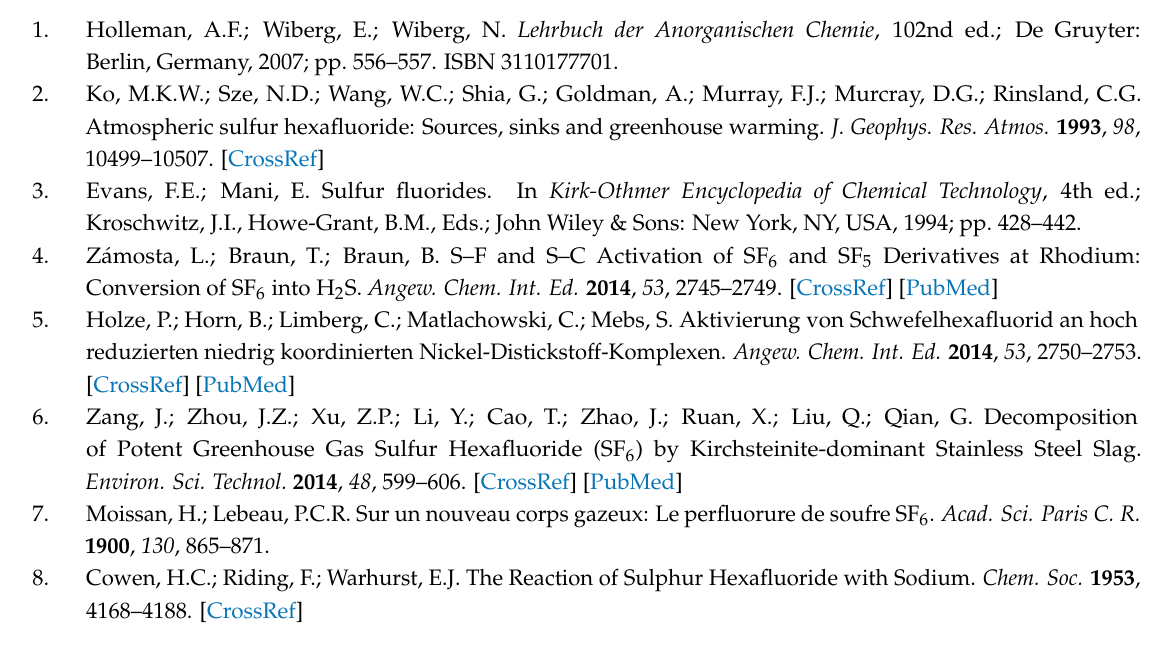
Figure S1: IR spectrum of RbF and Rb 2 S measured on an ATR diamond module, Figure S2: IR spectrum of SrF 2 and SrS measured on an ATR diamond